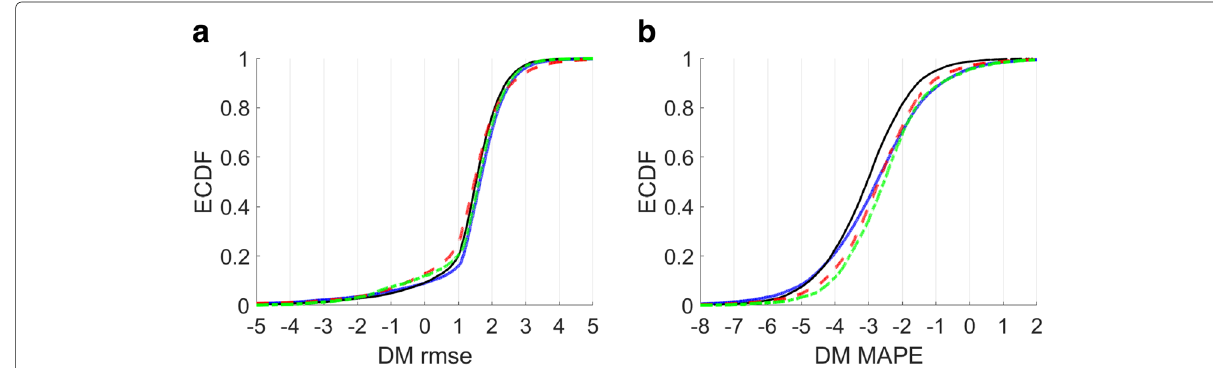
Fig. 5 ECDF for the DM test statistics for the validation sample and all (link,time-of-day-interval) combinations. a RMSE based, b MAPE based. Hietzing (blue), Westbahnhof (black, dotted), Ring (red, dashed), Südosttangente (green,